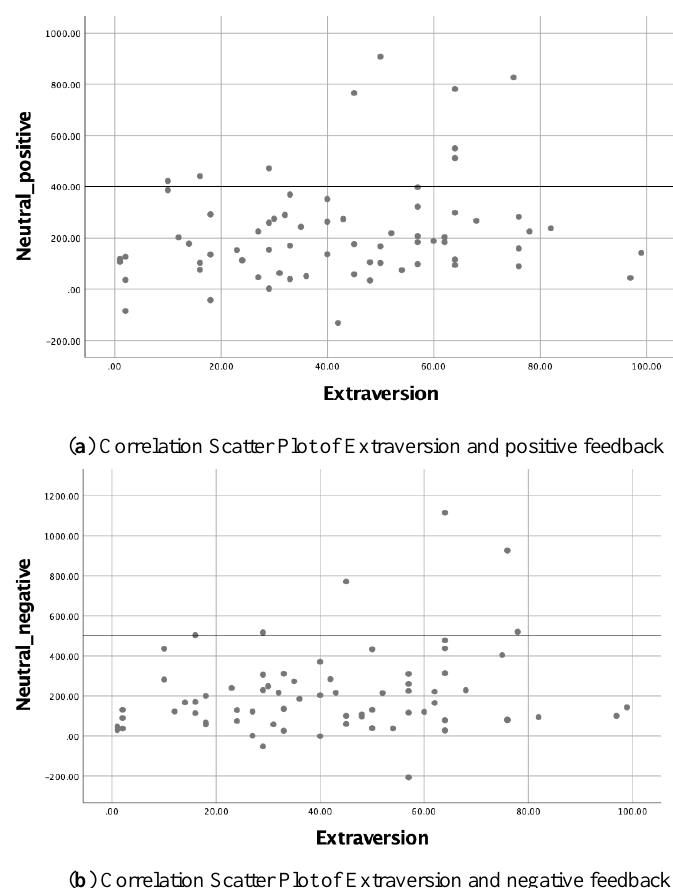
Figure 1. Correlation scatter plot of extraversion and style of feedback. ( a ) Correlation Scatter Plot of Extraversion and positive feedback, ( b ) Correlation Scatter Plot of Extraversion and negative